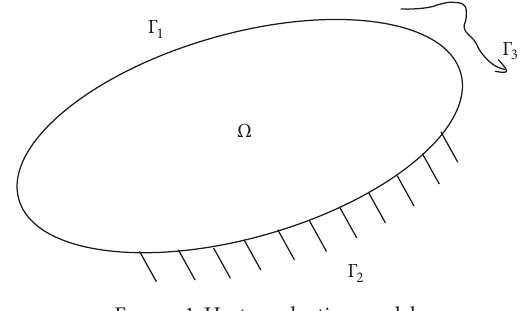
Figure 1: Heat conduction model.